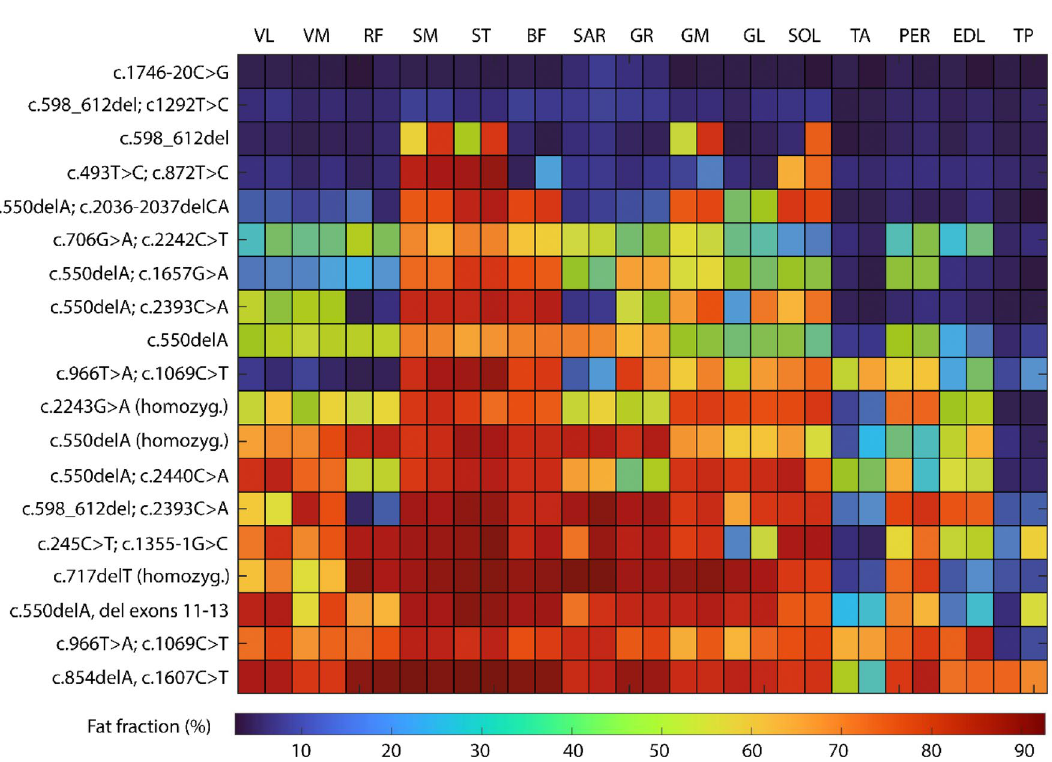
Figure 2. Overview of fat infiltration and mutations in calpainopathy patients. VL vastus lateralis, VM vastus medialis, RF rectus femoris, SM semimembranosus, ST semitendinosus, BF biceps femoris, SAR Sartorius, GR gracilis, GM gastrocnemius medialis, GL gastrocnemius lateralis, SOL soleus, TA tibialis anterior, PER peroneal group, EDL extensor digitorum longus, TP tibialis